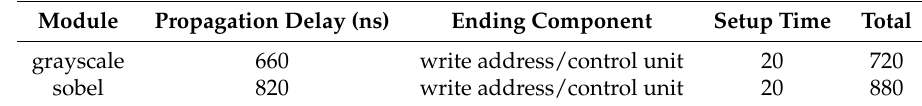
Table 2. Design Timing Analysis 2.